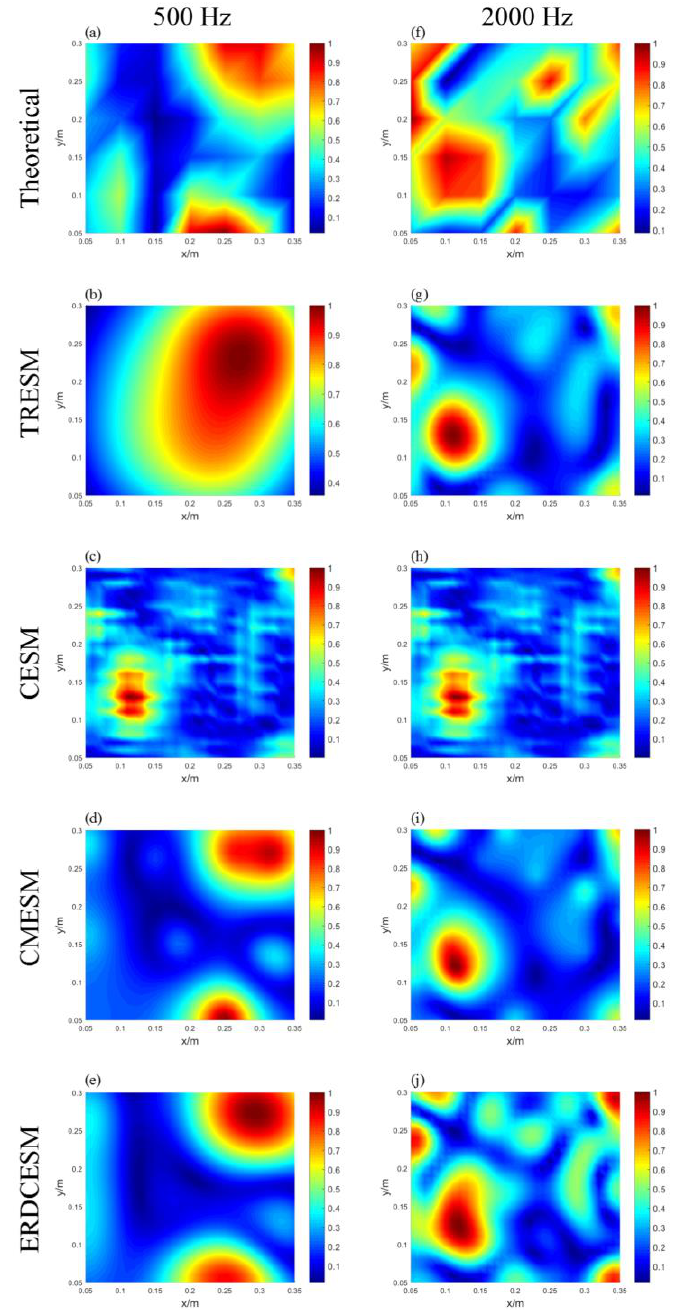
Figure 12. The Experimental results of (a) Theoretical map at 500Hz, (b) TRESM map at 500Hz, (c) CESM map at 500Hz, (d) CMESM map at 500Hz, (e) ERDCESM map at 500Hz, (f) Theoretical map at 2000Hz, (g) TRESM map at 2000Hz, (h) CESM map at 2000Hz, (i) CMESM map at 2000Hz and (j) ERDCESM map at 2000Hz for a plate sound source.